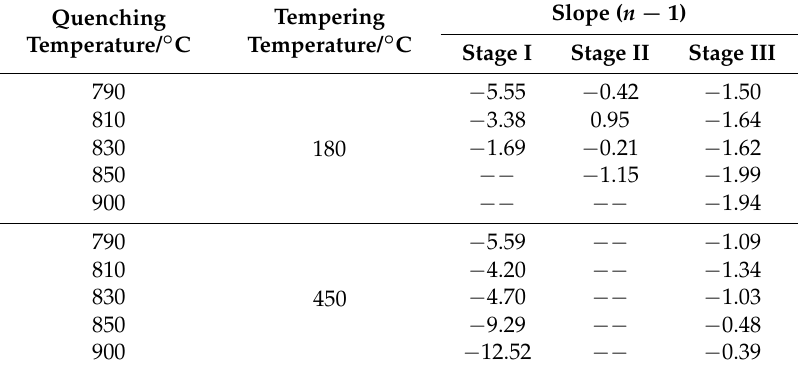
Table 3. Summary of the parameters related to strain hardening behavior of each heat treated